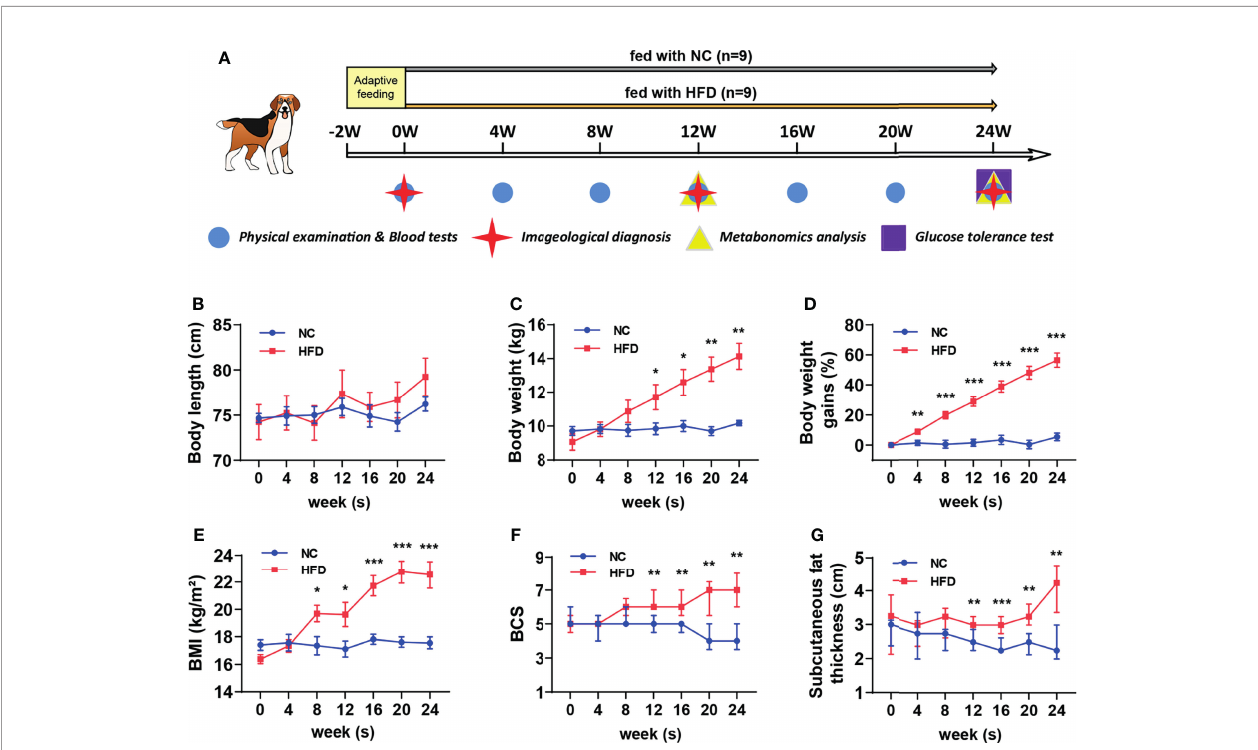
FIGURE 1 | Comparison of body features between dogs with high-fat diet-induced obesity and metabolic disorder and dogs fed with normal chow. (A) Schematic diagram of feeding, grouping and examining regimen in this study. After 2 weeks of adaptation, a preliminary examination was carried out, and then 18 beagles were randomly assigned to receive normal chow (NC) or a customized high-fat diet (HFD) for 24 weeks. (B – E) Body length, weight, percentage of body weight gain compared to the baseline and BMI from NC and HFD beagles. n = 9 per group. Data are expressed as the mean ± s.e.m. Signi fi cance levels * P <0.05, ** P <0.01, *** P <0.001. (F, G) BCS and subcutaneous fat thickness from NC and HFD beagles. n = 9 per group. Data are expressed as the median with interquartile range. Signi fi cance levels ** P <0.01, *** P